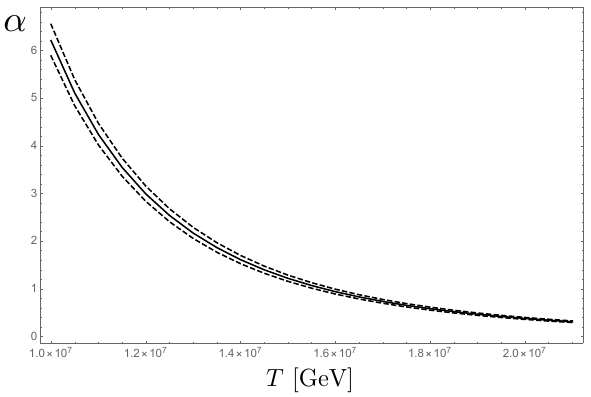
Figure 6 . Latent heat parameter (cid:11) as a function of temperature for representative choice of ’ 2 : 2 (cid:1) 10 7 GeV. In order to produce this plot, we have (cid:12)xed (cid:22) 1 = 0 : 09 f , parameters with T h 1 (cid:21) 1 = 0 : 05, (cid:20) 2 = 1 : 5, (cid:22) 2 = 0 : 1 f and f = 10 8 GeV. We also (cid:12)xed (cid:20) 1 = 3 (cid:22) 2 =f 2 , since the dependence 1 of (cid:11) on this parameter is very mild. The solid, dashed upper and dashed lower lines are obtained respectively for (cid:21) (cid:30) = 10 (cid:0) 3 ; 10 (cid:0) 4 ; 2 (cid:1) 10 (cid:0) 4 . Very similar curves can be obtained for smaller values of (cid:22) 1 and (cid:21) (cid:30) , starting at smaller values of T h , thus larger values of (cid:11) 1